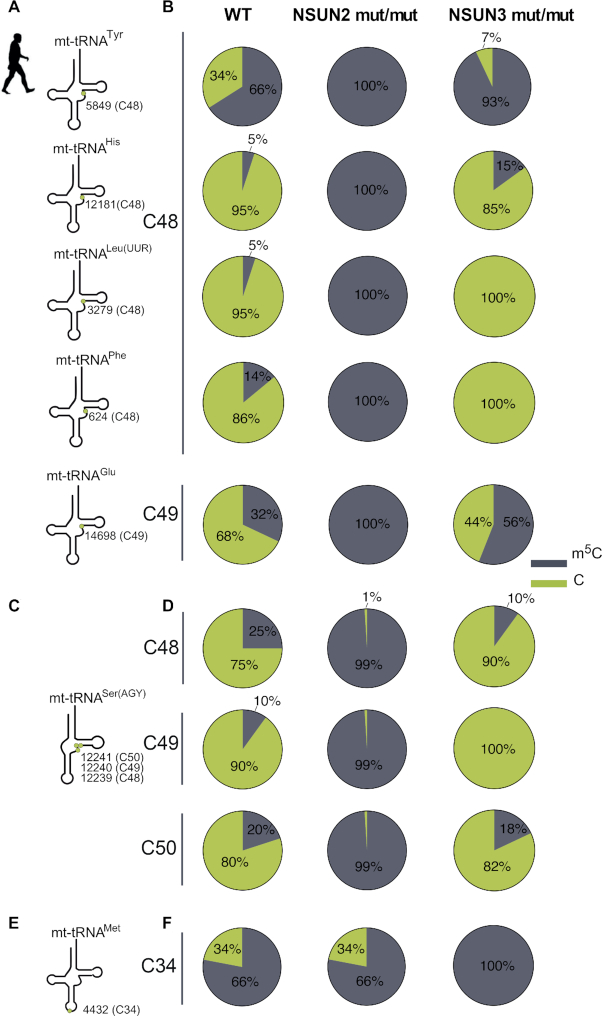
Human NSUN2 methylates mitochondrial tRNA postions 48–50. (A–F) Cytosine methylation of mt-tRNA of human fibroblasts. (A) Schematic structure of mt-tRNATyr, mt-tRNAHis, mt-tRNALeu(UUR), mt-tRNAPhe and mt-tRNAGlu. The green circles depict the positions of m5C in V-loop. (B) Summary of the BS RNA-Seq results for WT, NSUN2-null (NSUN2 mut/mut) and NSUN3-null (NSUN3 mut/mut) patient fibroblasts. (C) Schematic structure of mt-tRNASer(AGY) and the positions of m5C (green circles) in V-loop. (D) Summary of the BS RNA-Seq results for mt-tRNASer(AGY) for WT fibroblasts, NSUN2 mut/mut and NSUN3 mut/mut. (E) Schematic structure of mt-tRNAMet and the position of the precursor m5C (green circle) at position 34. (F) Summary of the BS RNA-Seq results for mt-tRNAMet for WT fibroblasts, NSUN2 mut/mut and NSUN3 mut/mut.